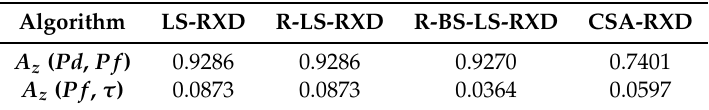
Figure 13. ROC analysis with different detectors: ( a ) curve of ( Pd , Pf ); ( b ) curve of ( Pf , τ ). Table 5. AUC values with different detectors.